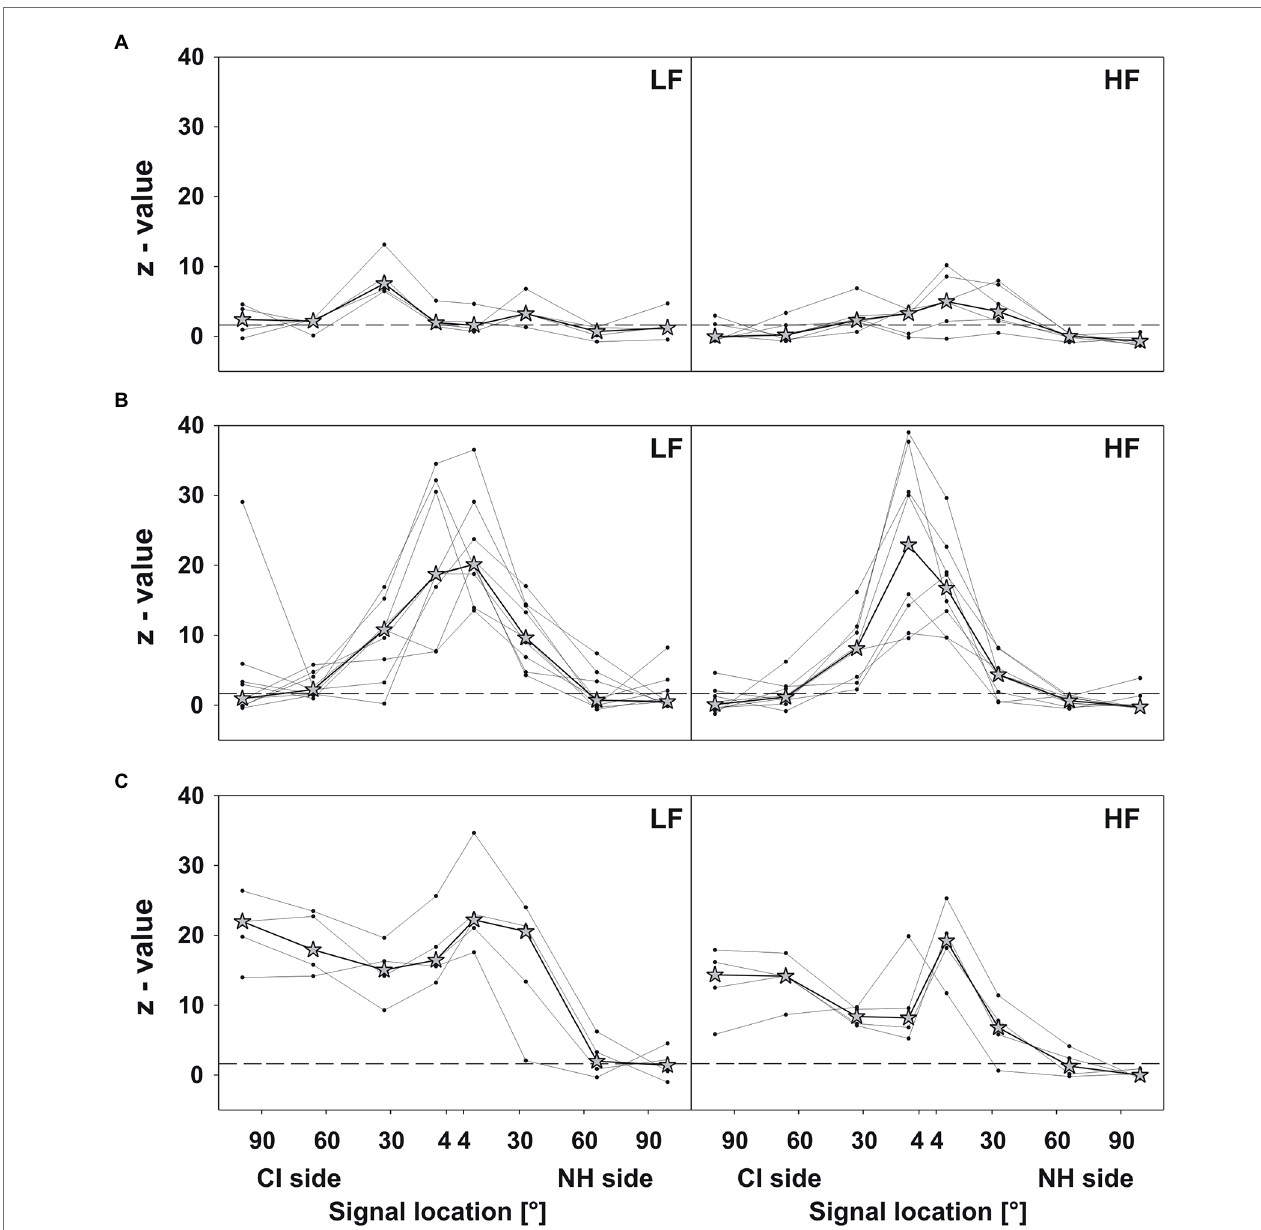
FIGURE 6 | Absolute localization. Z -values plotted against the signal location for LF (left panels) and HF (right panels) signals. The dashed lines depict the significance level (1.64). Dots depict the z -value compared to the actual sound source location for every participant, separately. Asterisks depict the respective median of the group. Three different response patterns were evident: (A) good performance (at least four z -values below or nearby 1.64), (B) reduced accuracy at frontal locations, and (C) reduced accuracy on the CI